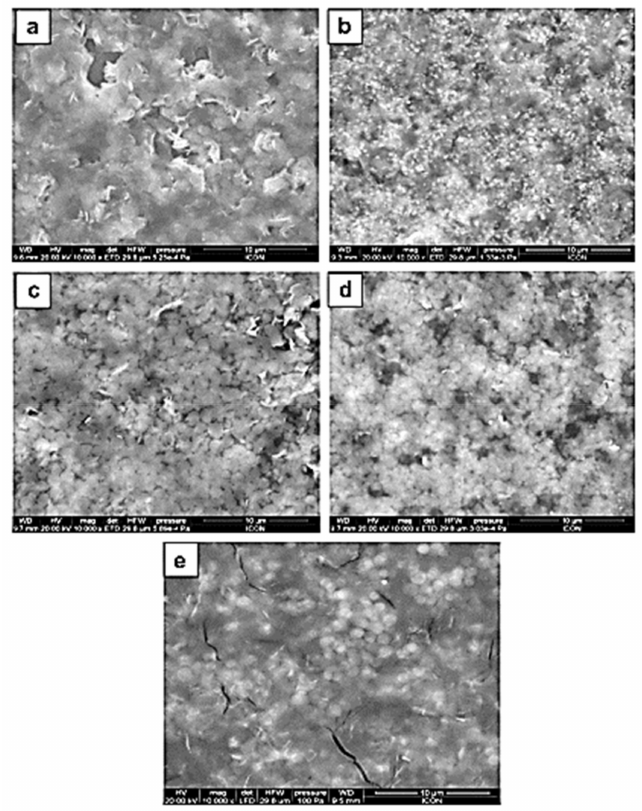
Figure 2. SEM images reported in the work of Patil et al.: ( a ) polyaniline (PANI)–ZnO with 10% of camphor sulfonic acid (CSA); ( b ) PANI–ZnO with 20% CSA; ( c ) PANI–ZnO with 30% CSA; ( d ) PANI–ZnO with 40% CSA and ( e ) PANI–ZnO with 50% CSA. Reproduced from [53] with permission from Elsevier (License number